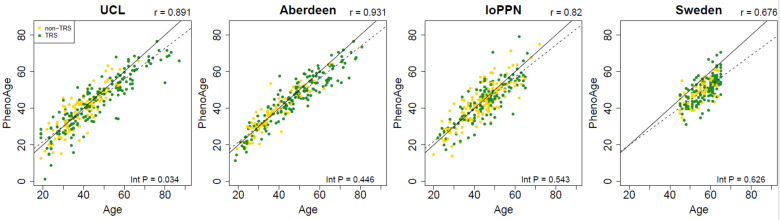
Scatterplots of PhenoAge derived from the DNA methylation data against actual chronological age for each of the cohorts.PhenoAge was calculated using the algorithm described by Levine et al., 2018. Each point represents an individual and is colored by schizophrenia status (yellow = schizophrenia cases not prescribed clozapine, green = treatment-resistant schizophrenia cases prescribed clozapine). The solid diagonal line depicts x=y, that is, where the estimated and actual values are the same. The dashed diagonal line depicts the line of best fit. Presented at the top of the graph is the Pearson’s correlation coefficient (r) between the estimated and actual age across all samples in that cohort. Also shown in the bottom right-hand corner of each panel is an interaction p-value from a test for different correlations between PhenoAge and actual age for schizophrenia patients prescribed clozapine and schizophrenia patients prescribed alternative medications.